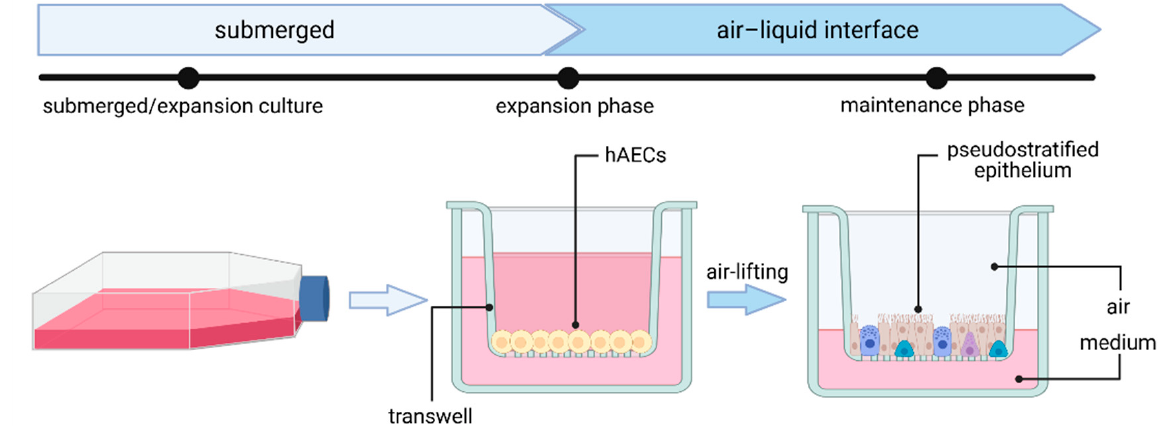
Figure 2. Generation of human airway epithelial cell culture in air–liquid interface (ALI) from human airway epithelial cells (hAECs). Figure created with BioRender.com (accessed on 28 April 2021).